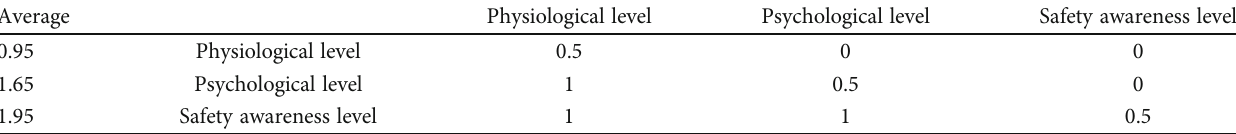
Table 4: Weight calculation table of precedence chart.